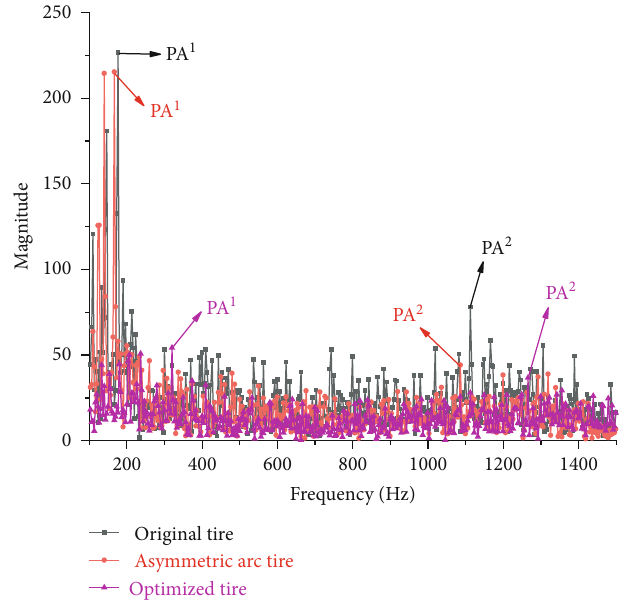
Figure 22: The spectrum comparison between the optimized tire, original tire, and asymmetric arc